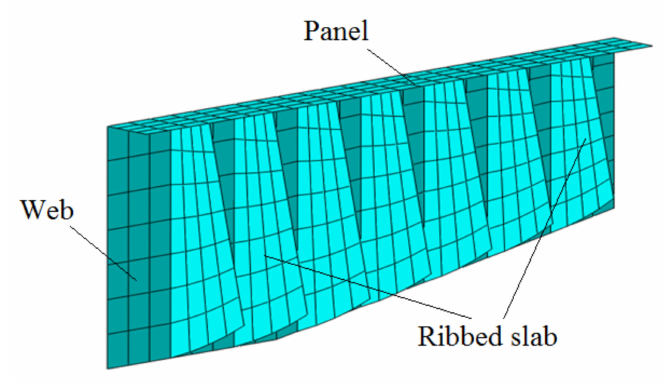
Figure 11. Location of the damping on the base.